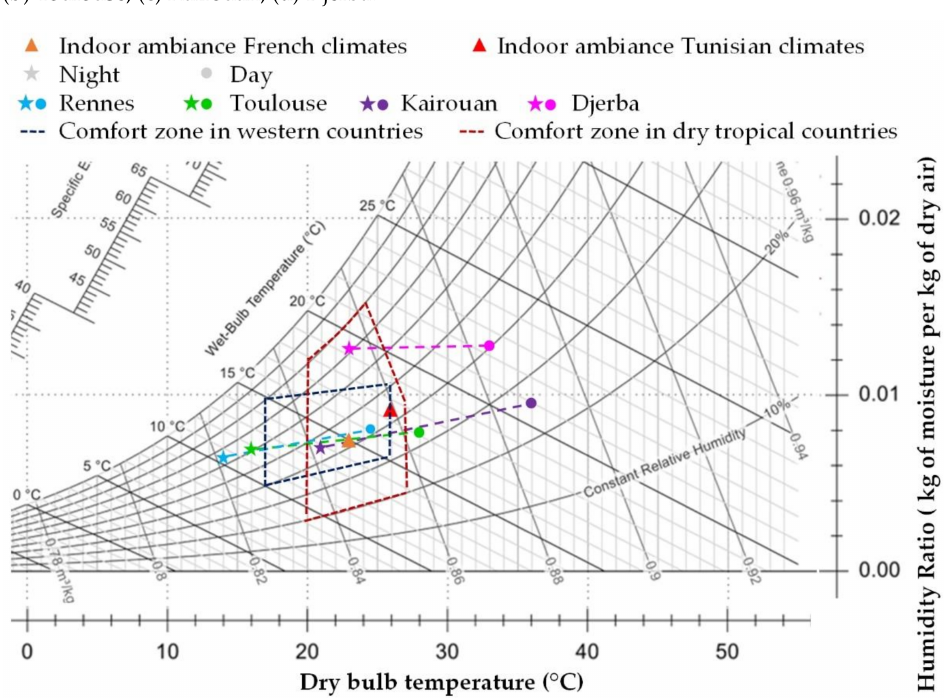
Figure 4. Boundary conditions: indoor and outdoor temperatures and relative humidities for the four